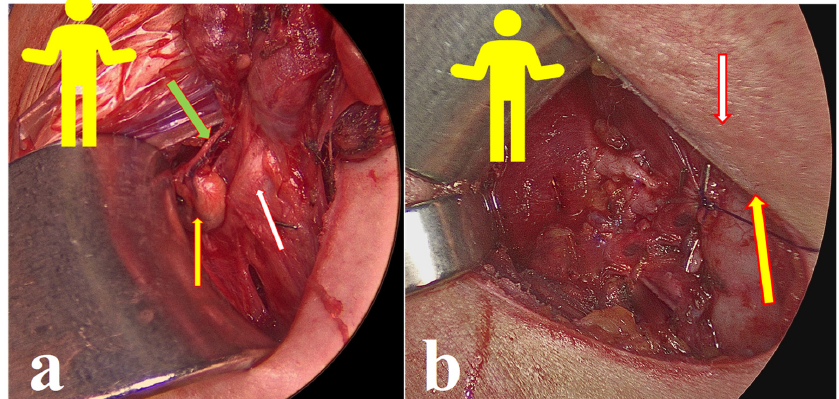
Figure 4. ( a ) The yellow figure simulates the patient position on the OT table. The white arrow shows the second non-RLN type 1. The yellow arrow shows the upper parathyroid and the green arrow indicates the blood supply of the upper parathyroid. ( b ) The yellow arrow shows non-RLN type 1 and the white arrow shows the upper parathyroid.